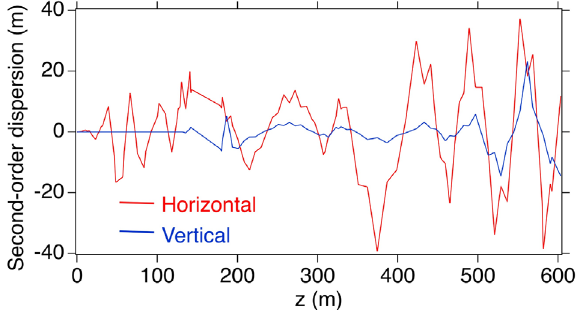
FIG. 9. Second-order geometrical dispersion functions of XSBT in the horizontal (red line) and vertical (blue line)